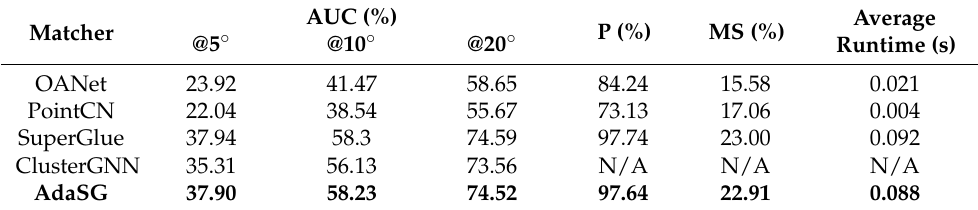
Figure 11. The visualized matching result on YFCC100M. The red lines represent mismatches, and the green lines represent correct matching. ( a ) The results of OANet. ( b ) The results of SuperGlue. ( c ) The results of AdaSG. ( d ) The other results of OANet. ( e ) The other results of SuperGlue. ( f ) The other results of AdaSG.